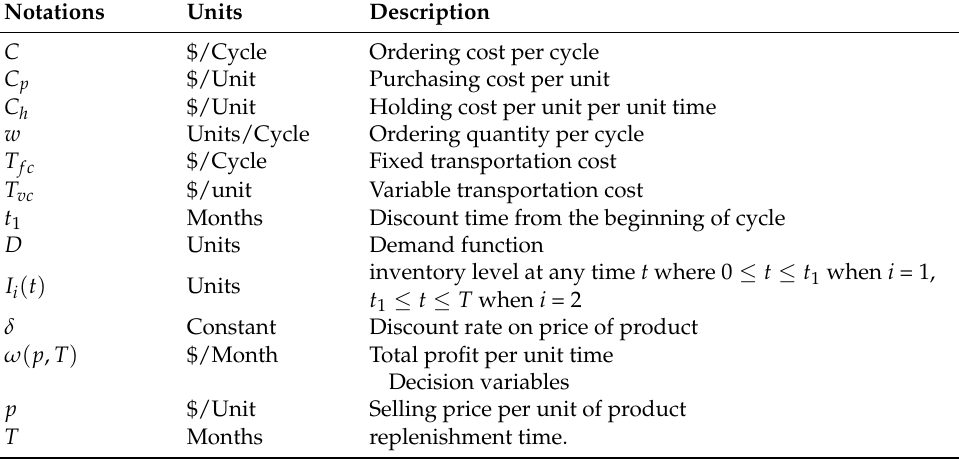
Table 1. Notations